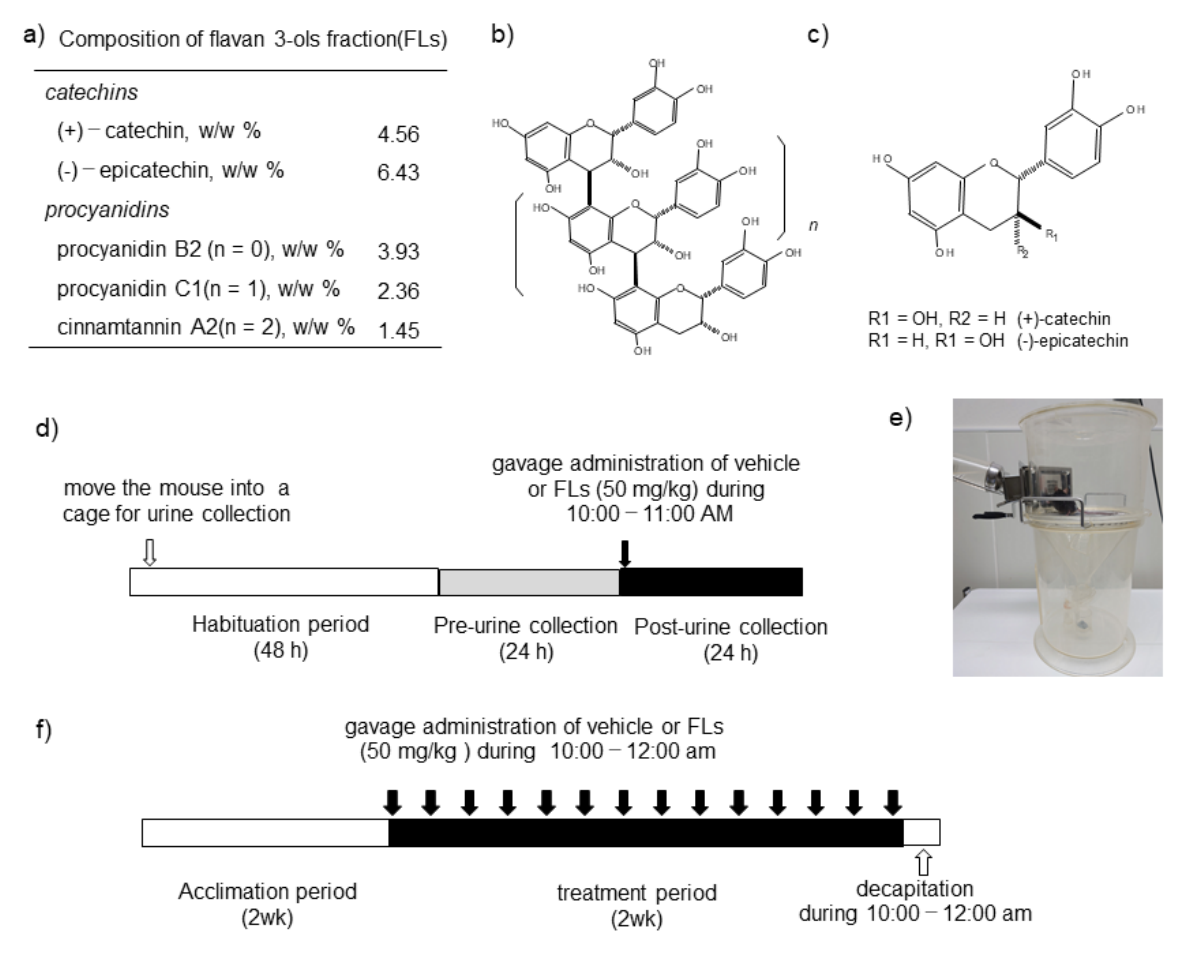
Figure 1. Composition of flavan-3-ols fraction (FLs) and scheme of experimental procedures. Composition of flavan-3-ols fraction (FLs) ( a ), the structure of B-type procyanidins ( b ), the structure of catechins ( c ), the scheme for the experimental procedure to determine urinary catecholamines (CAs) following a single dose of FLs ( d ), photo of the cage for urine collection ( e ), the scheme for the experimental procedure to examine the impact of repeated administration of FLs on adipose tissue in mice ( f ).